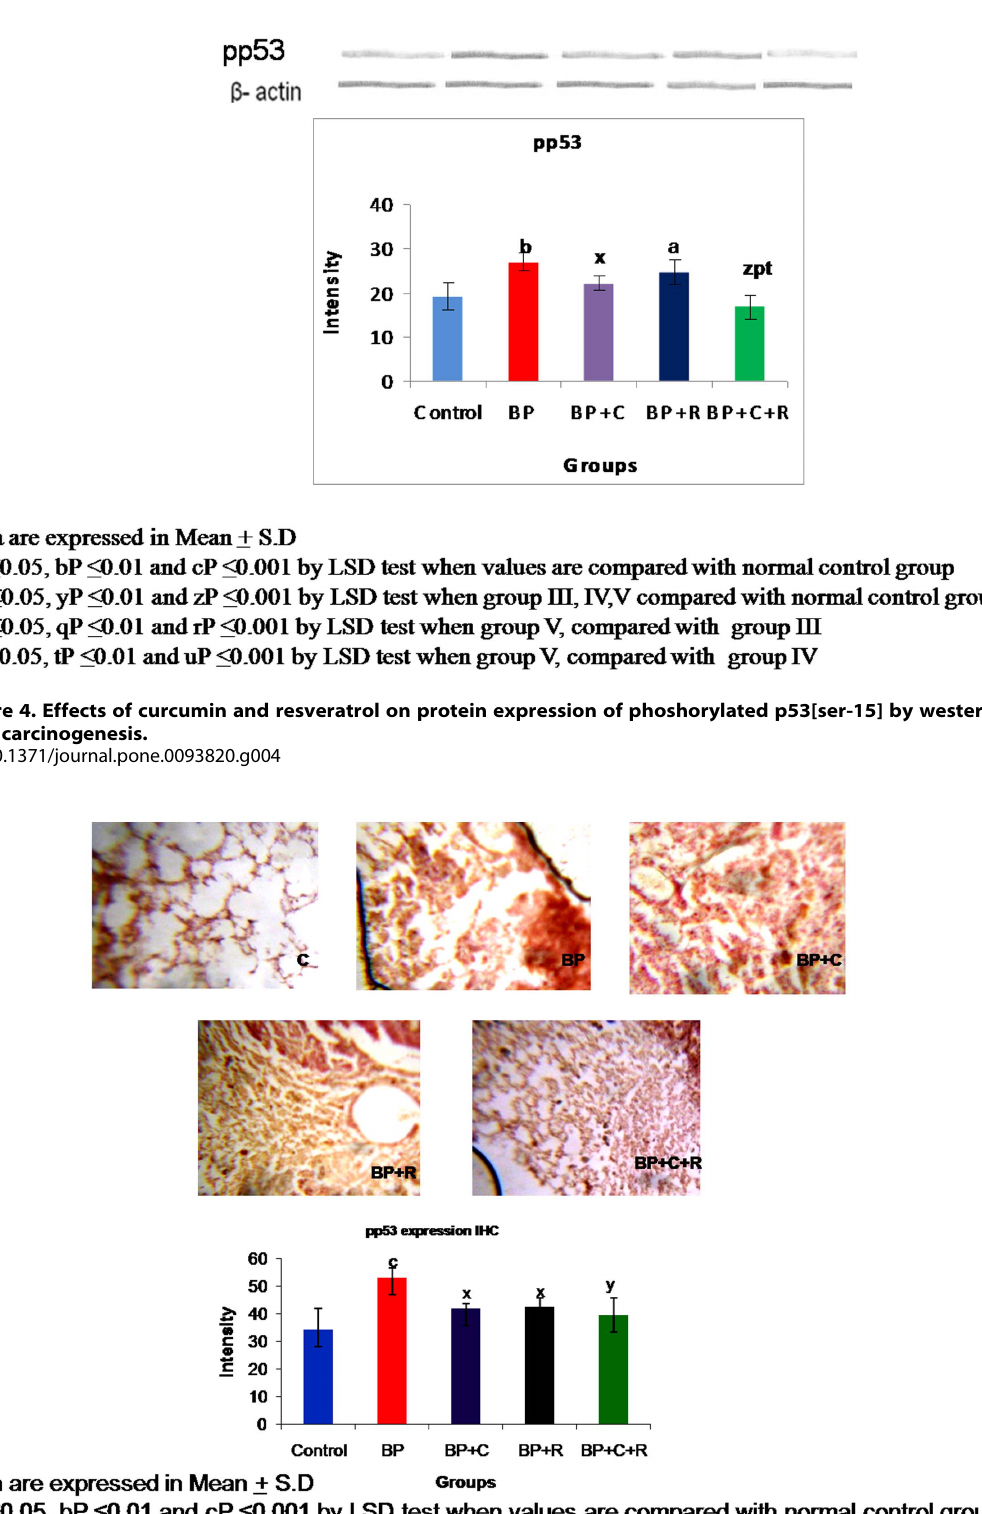
Figure 5. Effects of curcumin and resveratrol on protein expression of phoshorylated p53[ser-15] by Immunhistochemistry [IHC at 10 6 magnification] during lung carcinogenesis. doi:10.1371/journal.pone.0093820.g005 PLOS ONE |